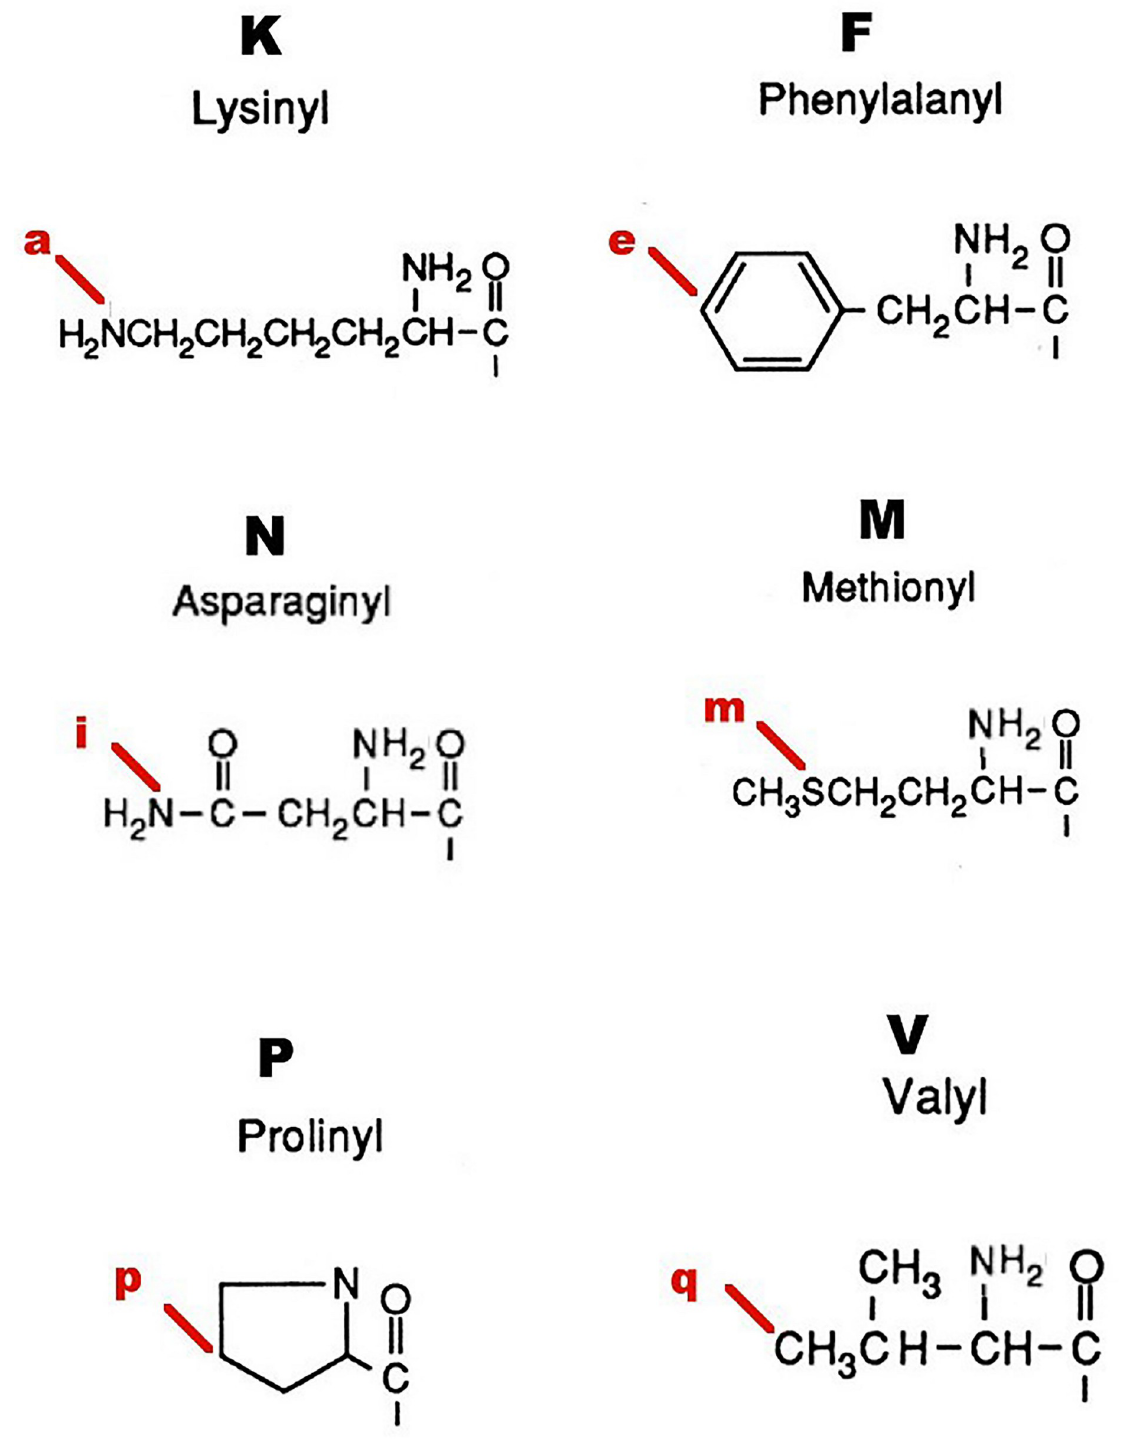
Fig 8. Atoms for interatomic distances.